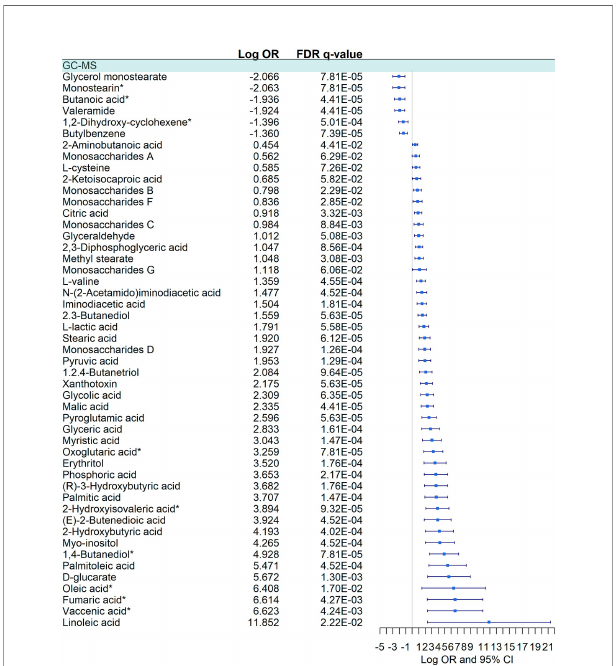
FIGURE 2 | Pairwise comparison of GC-MS metabolites between COVID+ and COVID- individuals. Statistics: Logistic regression adjusted for age and sex was used. The False Discovery Rate (FDR) was used to cope with multiple testing, and q-values are provided. Monostearin*: Monostearin/1-stearoyl-rac-glycerol. Butanoic acid*: Butanoic acid. 2- (methoxyimino)-3-methyl-. trimethylsilyl ester. 1,2-Dihydroxy-cyclohexene*: 1.2-Bis(trimethylsiloxy)cyclohexene. Oxoglutaric acid*: Alpha-ketoglutaric acid. 2-Hydroxyisovaleric acid*: 2-Hydroxy-3-methylbutyric acid/Pentanoic acid 2-[(trimethylsilyl)oxy]-, trimethylsilyl ester. 1,4 - Butanediol*: (R*,S*)- 3,8-Dioxa-2,9-disiladecane, 2,2,9,9-tetramethyl-5,6-bis[(trimethylsilyl)oxy].